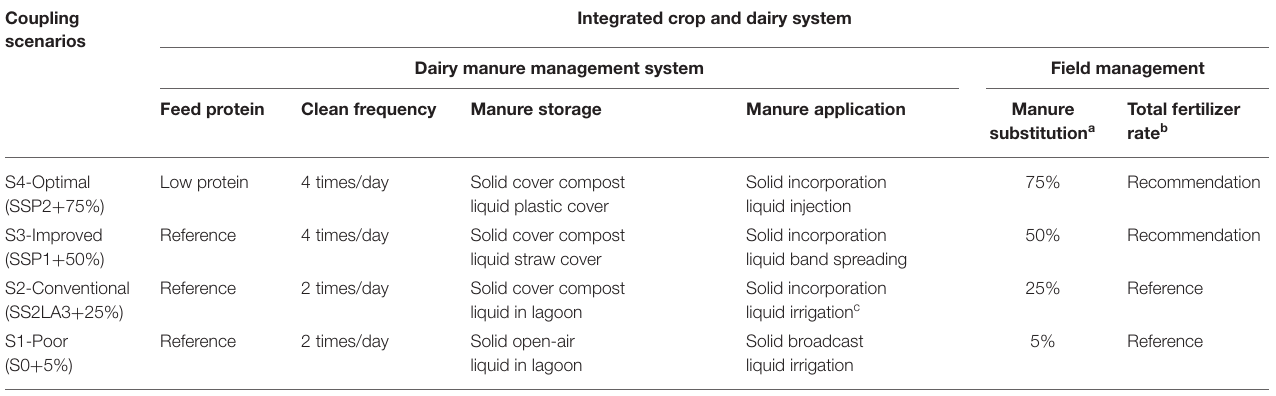
TABLE 3 | Scenario settings under different management levels of dairy cattle-crop system. Coupling